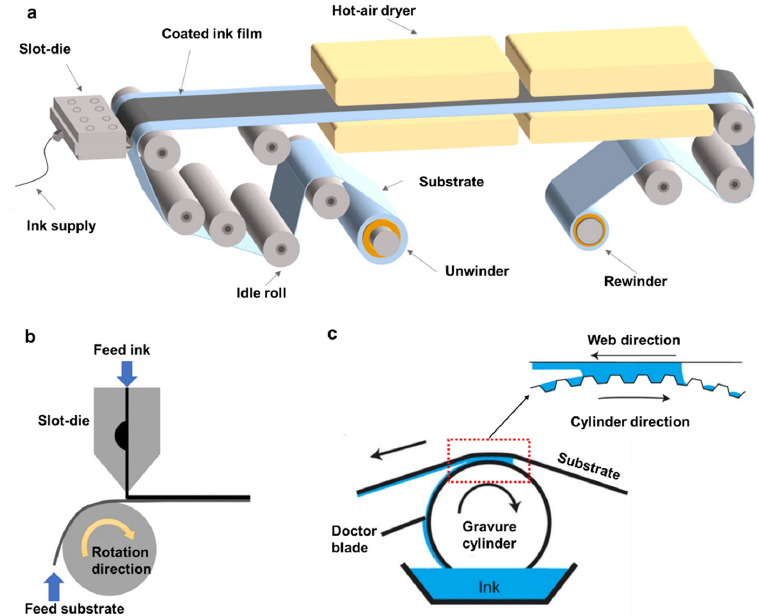
Figure 12. ( a ) Schematic of the roll-to-roll manufacturing process coupled with slot-die coating, (Reprinted from [165], Copyright (2020), with permission from Elsevier), ( b ) illustration of slot-die coating (Adapted from [39], Copyright (2019), with permission from Elsevier), ( c ) illustration of gravure coating (Adapted from [38]).